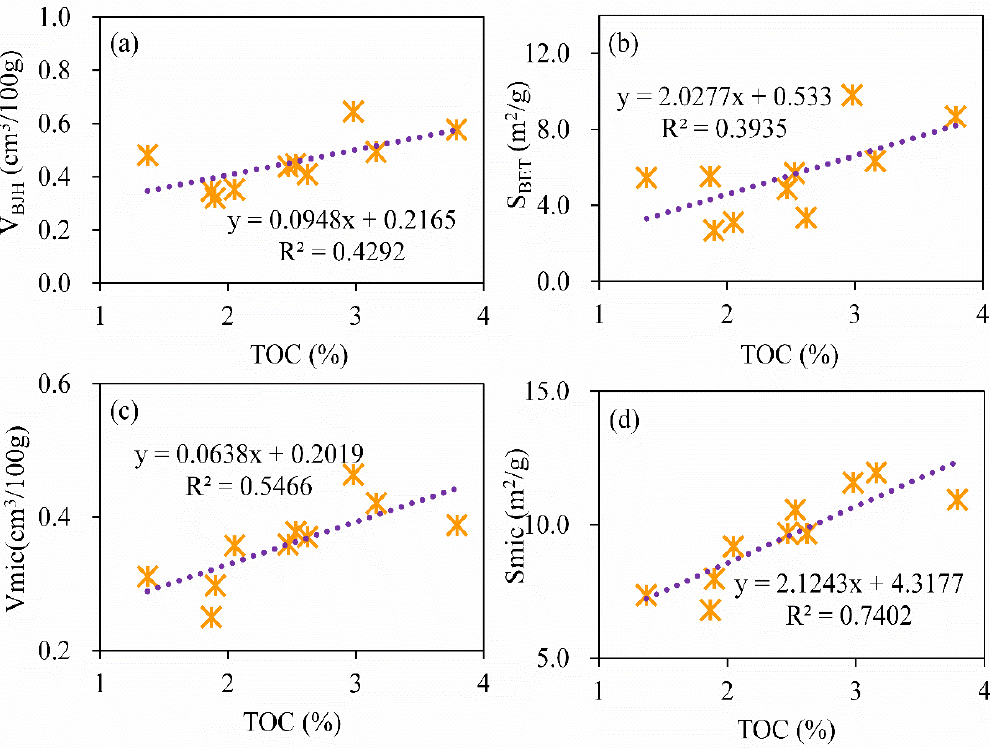
Figure 12. Correlations of TOC with pore structure parameters of the YC2 samples. Subfigures ( a – d ) show a good correlation between TOC and pore structure parameters. See details in text.